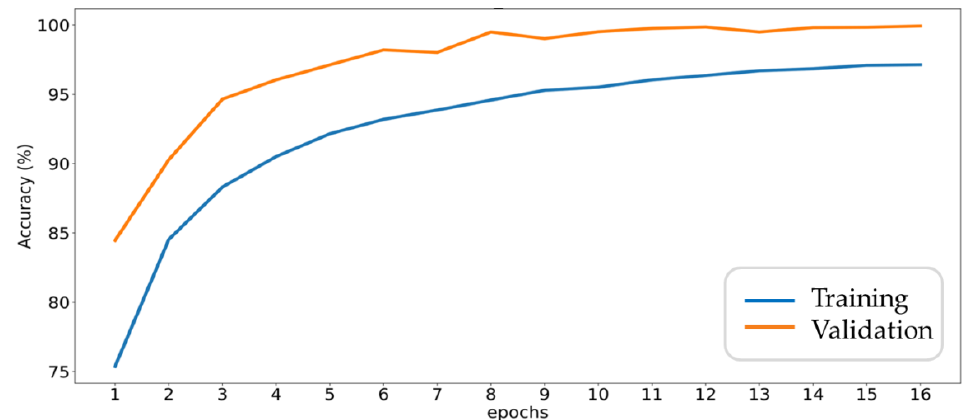
Figure 14. Accuracy trends during the training and validation process.